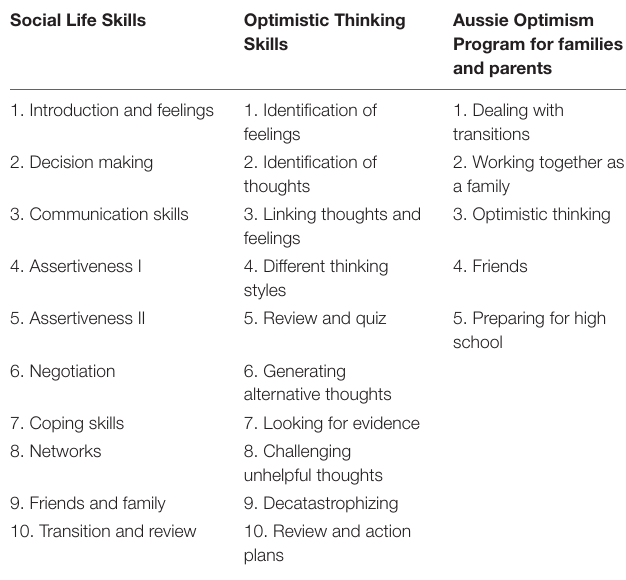
TABLE 2 | Content of the Aussie Optimism Program